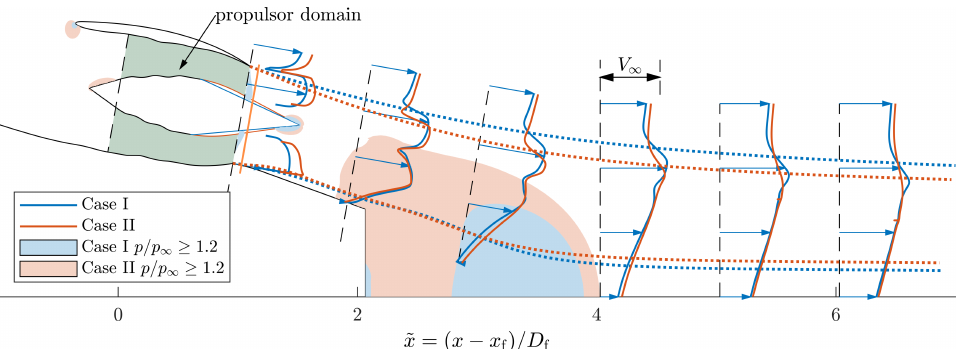
Figure 12. Exhaust jet velocity profiles at the centre plane. The streamlines showing the extent of the exhaust jet are in dotted lines. The regions of p / p ∞ 1.2 are shaded, with the case I region overlaid ≥ onto case II. The orange line ( ) denotes the cut plane for Figure 11.